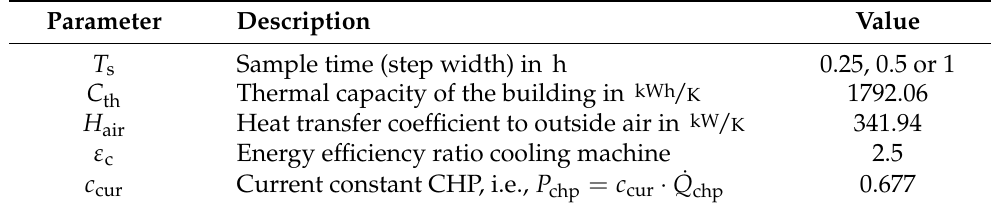
Table 1. Building model parameters for System (2).